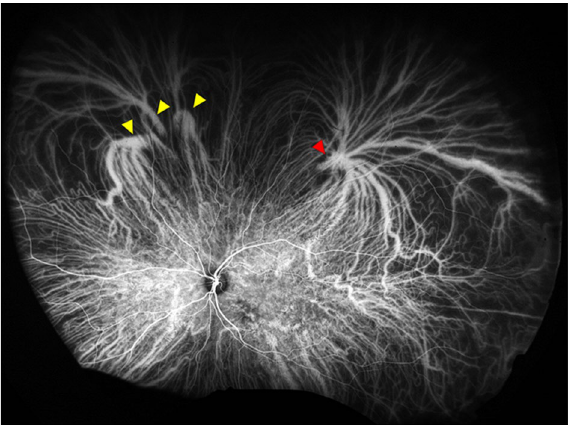
Figure 4. Image of indocyanine green fundus angiogram of the left eye taken by Optos California in an early phase. The differences in the forms of the vortex vein ampulla between upper lateral sector (red arrowhead) and upper nasal sector (yellow arrowhead). The vortex veins converged after passing through the scleral surface in the upper nasal sector, on the other hand, they converge before entering the sclera in the upper lateral